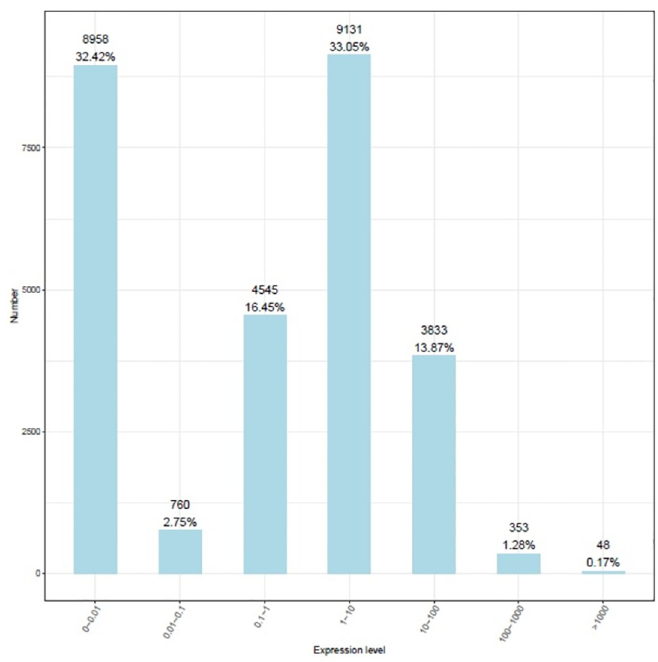
Fig 3. Plant gene expression during the interaction with B . aryabhattai . The X-axis represents the range of gene expression values, and the Y-axis represents the number of genes in each expression interval.